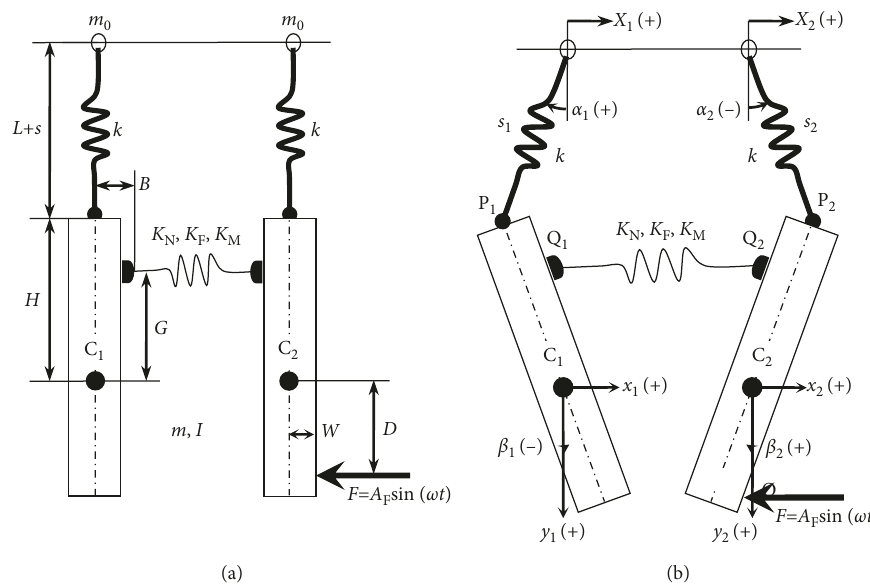
Figure 2: A simplified in-plane model of the shaft bending fatigue testing machine. (a) Equilibrium status, (b) vibrating status.